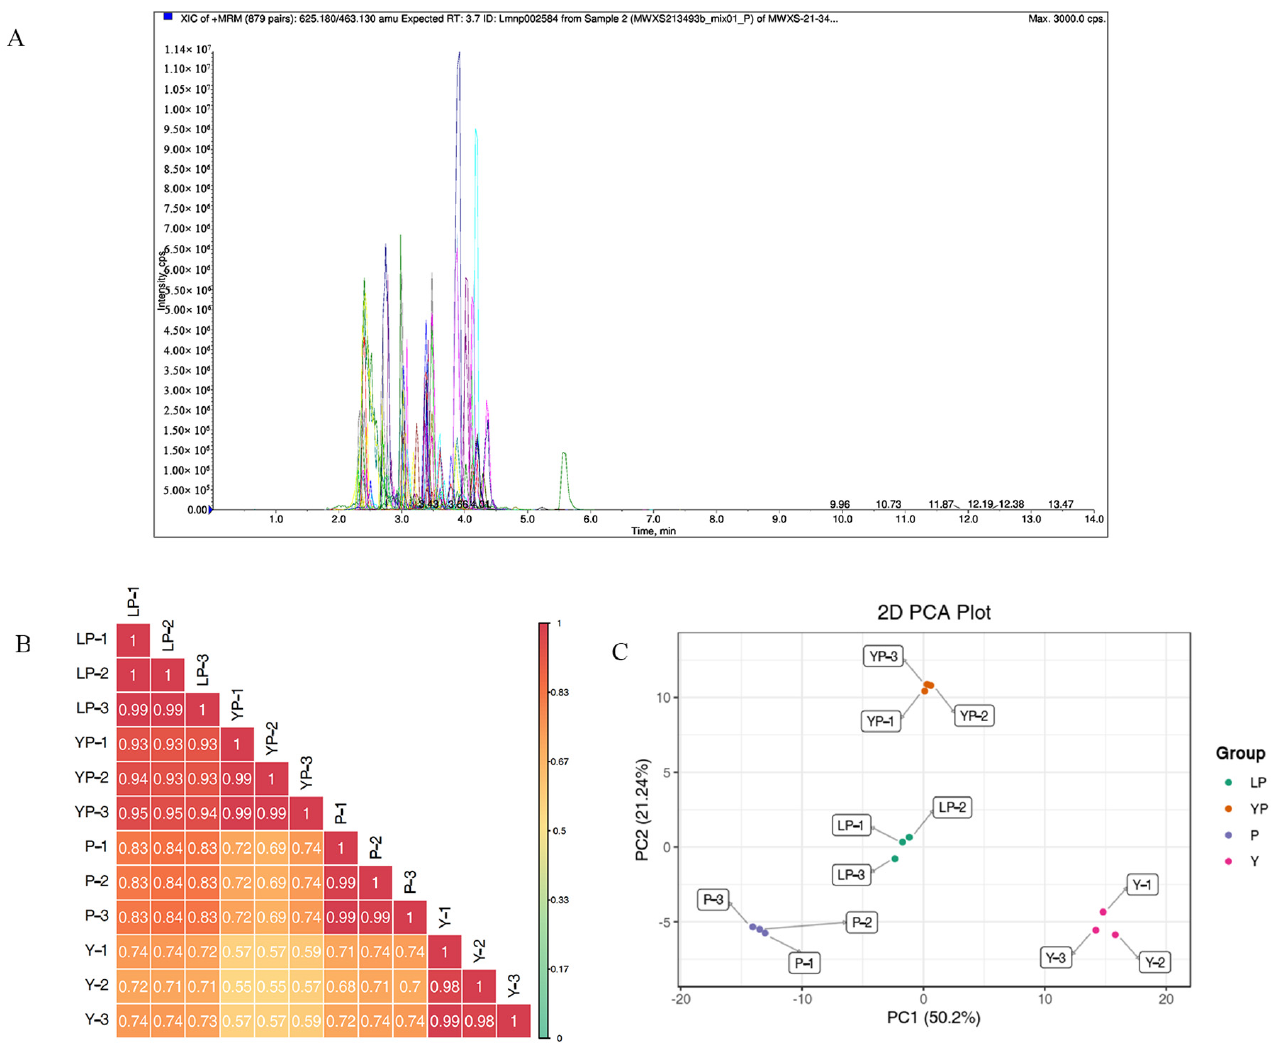
Figure 3. Overall qualitative and quantitative analyses of metabolomics data. ( A ) TIC overlap map of QC samples by MS detection. Abscissa represents the retention time (min) of metabolite detection. Ordinate represents the intensity of ion current (cps: count per second). ( B ) Pearson’s correlation coefficients among Y, LP, YP, and P. ( C ) PCA of Y, LP, YP, and P. X -axis represents the first principal component. Y -axis represents the second principal component.